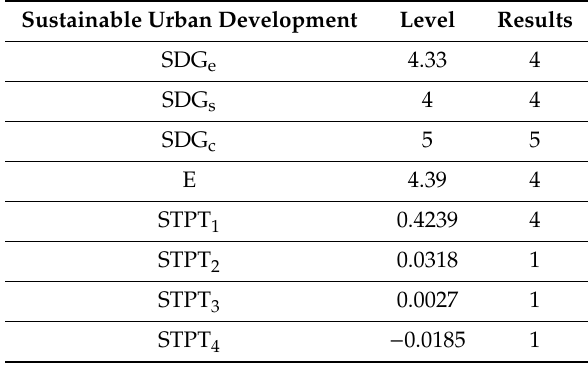
Table 5. Sustainable urban development card for a Polish